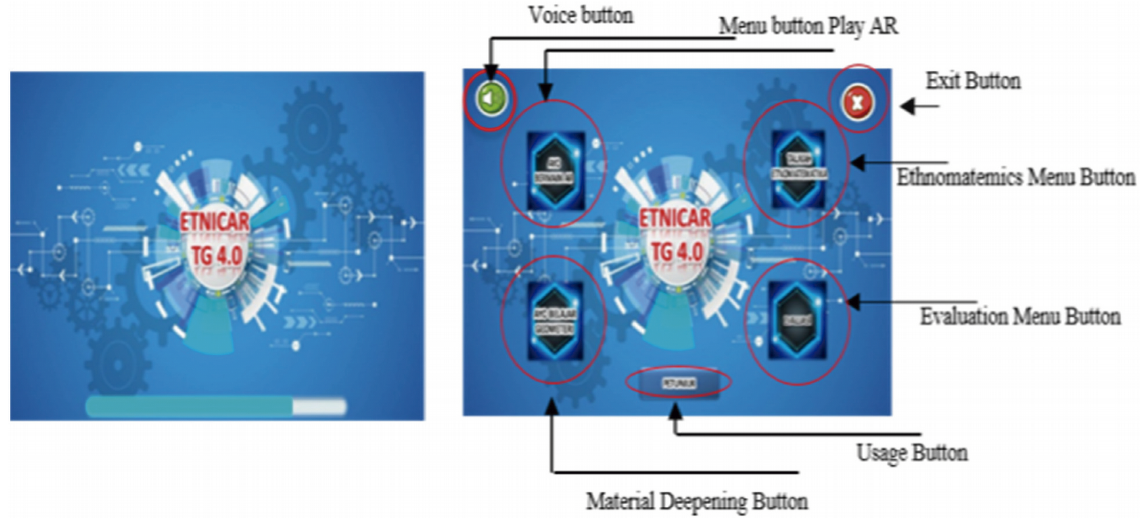
Figure 2. Menu and Display of Mobile Augmented